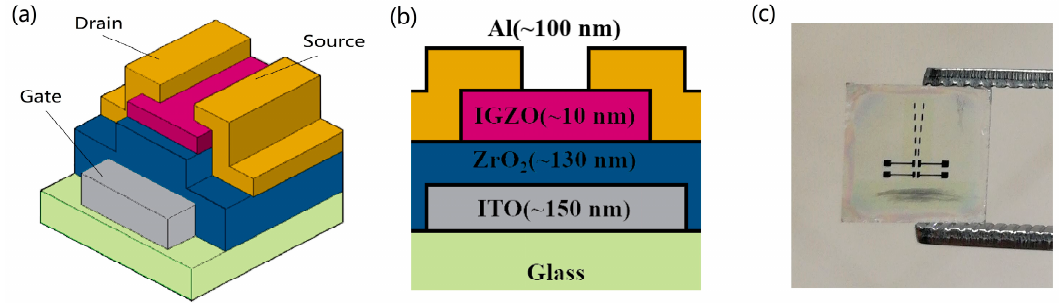
Figure 4. ( a ) Schematic showing the cross-section of IGZO-TFT with ZrO 2 dielectric layer. ( b ) Thickness of each layer. ( c ) Photograph of the fabricated TFT. Appl. Sci. 2018 , 8 , x; doi: FOR PEER REVIEW